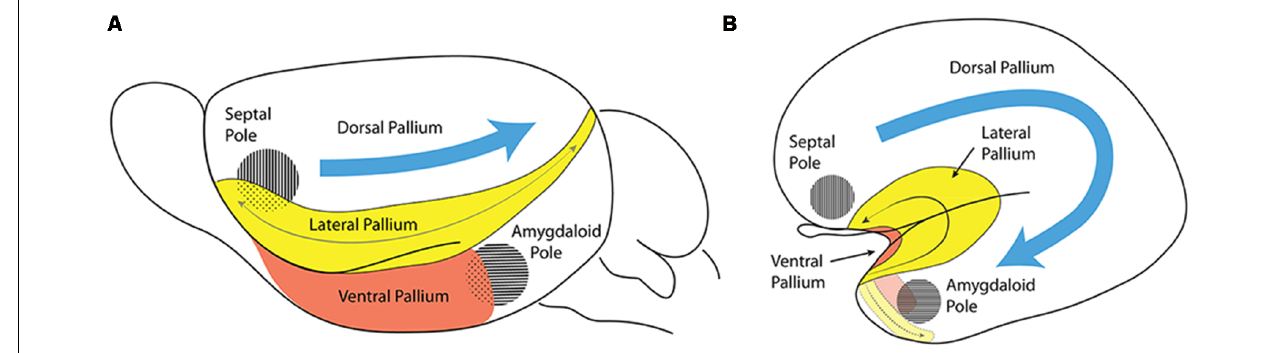
FIGURE 4 | Comparison of the lateral pallium (LP) long axis in a rodent (A) and a primate (B) . These schemata represent the invariant position of the insular/perirhinal mesocortex (LP) relative to the olfactory cortex (ventral pallium, VP) and the primary septal and amygdalar poles of the hemisphere in a rodent (A) and in a primate (B) . The length axis of the rodent LP enclosing the claustroinsular complex is relatively undistorted (gray arrow, A ), whereas the length axis of the primate LP undergoes a complex deformation. The frontal tip of LP points into the posterior orbital region of the frontal lobe, its middle part gets bent upon itself to form the insular cortex, and its caudal tip sharply bends around the medial aspect of the temporal pole (gray arrow, B ). Note the VP (red) can be easily distinguished underneath the LP (yellow) in rodents (A) , while its topologically invariant position is found in the primate along the insular limen and ending caudally next to the uncal amygdalar complex. Consistently with the deformation suffered by the length axis of LP and VP as the temporal lobe emerges, the conserved topologic dorsoventral dimension now points from the insula into the insular limen. By using the septal and amygdalar poles as reference points, it is evident that the LP, which is dorsal to the amygdaloid pole in a rodent, acquires a quite different relative topography in the temporal lobe in primates. In primates, the long axes of both the LP and VP start flat rostrally, approximately on the horizontal plane, but becomes oriented vertically as the axis curves under the temporal pole and reaches the underside of the temporal